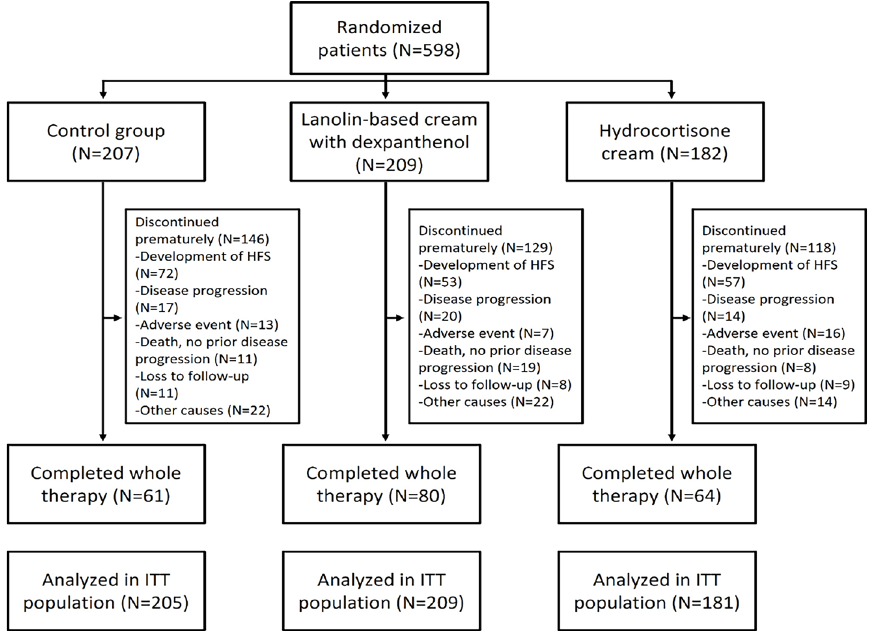
Figure 1. Patient flow during the study. Abbreviations: HFS = Hand-foot syndrome; ITT =